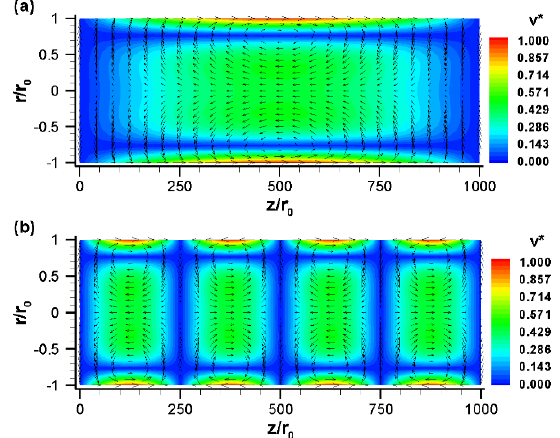
(cid:12) (cid:12) → (cid:12) (cid:12) v V u  (cid:12) (cid:12) HS V / u HS (contour (cid:12) (cid:12)